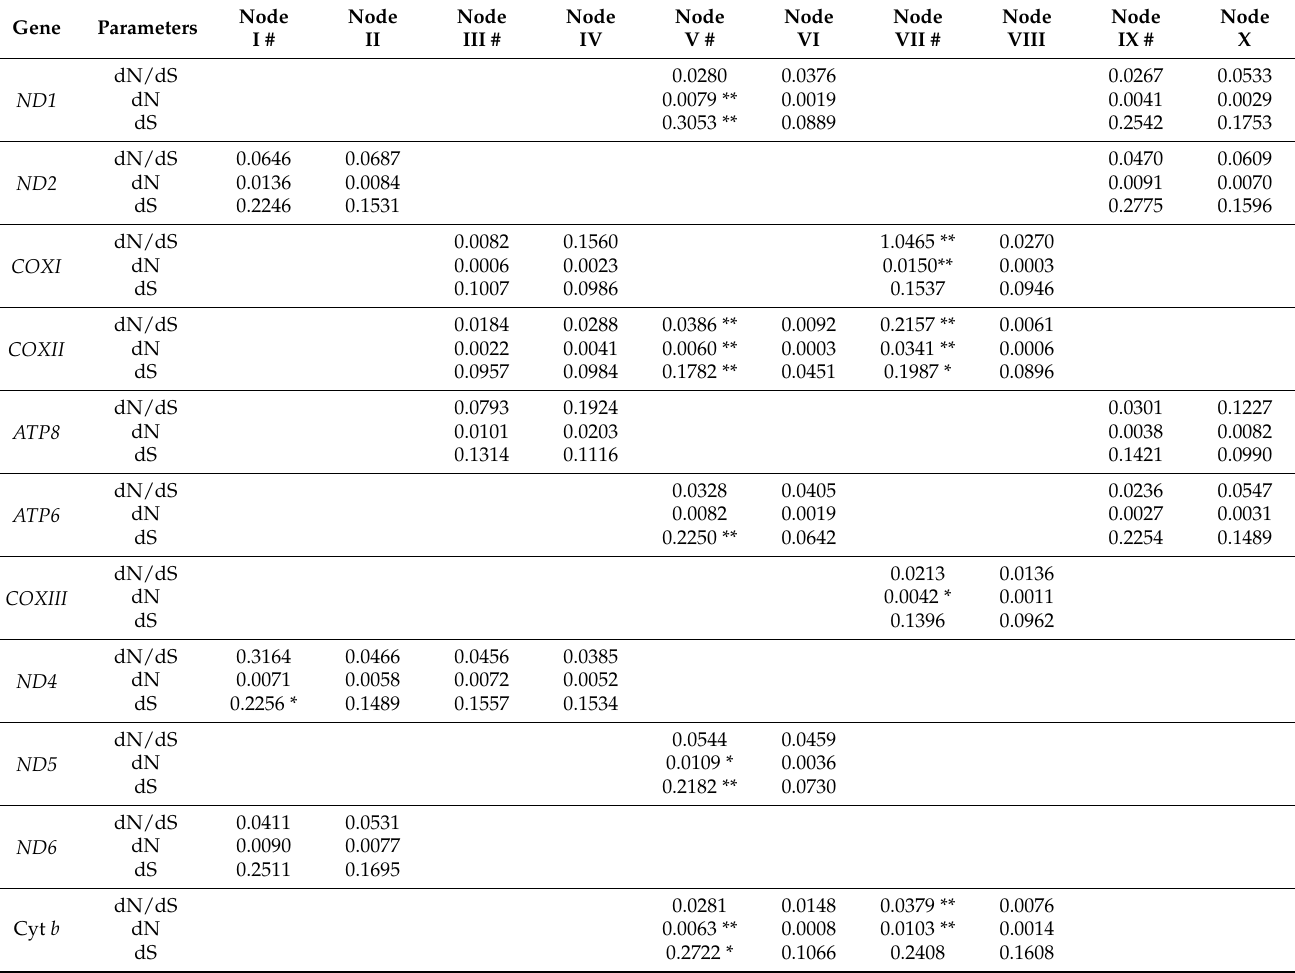
Table 3. Statistical analyses of mean dN/dS, dN, and dS values under branch model for genes among five pairs of clades in the Pseudogobionini